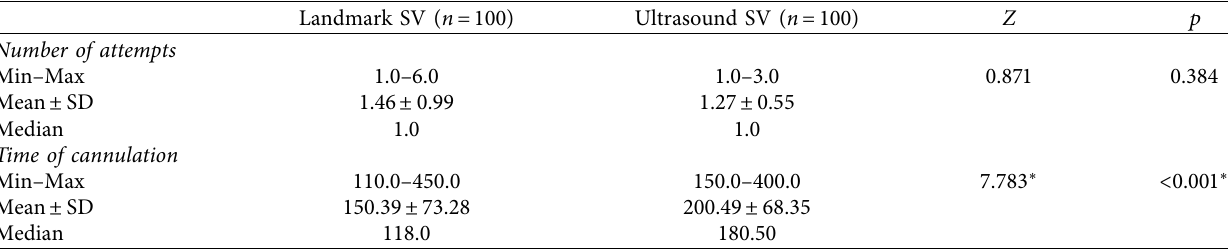
Table 6: Comparison between landmark and ultrasound in SV group (B) according to the number of attempts and time of cannulation.